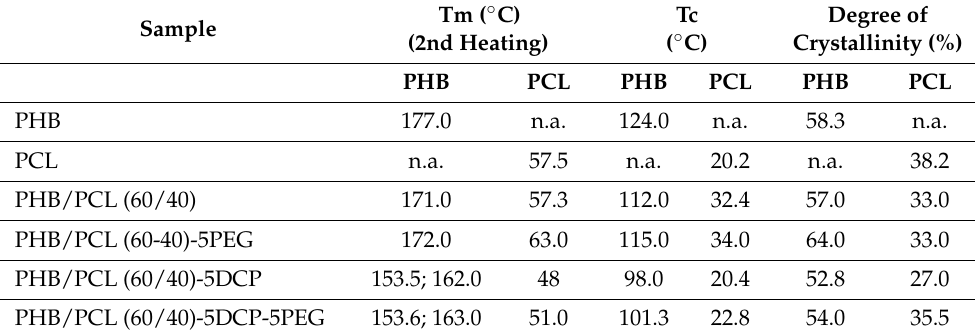
Figure 1. DSC thermograms of PHB, PCL and PHB/PCL blends: cooling step ( A ), second heating step ( B ). Table 3. DSC data of PHB, PCL and PHB/PCL-based materials.